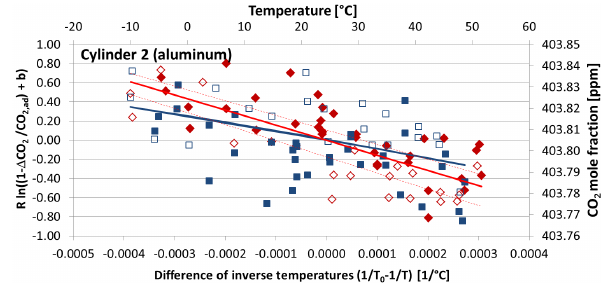
Figure 8. Dependence of scaled CO 2 mole fraction difference plus offset b on the difference of inverse temperature for the aluminium cylinder 2 according to Eq. (6). Open red symbols correspond to decreasing and filled red symbols to increasing temperature in Fig. 1 together with their corresponding correlation lines (dotted red lines). The red line corresponds to all values. The slopes corre- spond to the negative desorption energy (Eq. 6) as we have changed the x axis as in Fig. 7. The correlation is rather weak ( r 2 = 0.6). Part of the variability might be due to temperature-induced effects that are independent of adsorption/desorption phenomena. Hence care has to be taken with desorption energies of 1.53kJmol − 1 in- creasing to 1.68kJmol − 1 for decreasing temperature with a mean of 1.58kJmol − 1 . Open and filled blue symbols correspond to the CO 2 mole fractions vs. temperature, whereas the blue line corre- sponds to the estimated CO 2 mole fractions according to Eq.